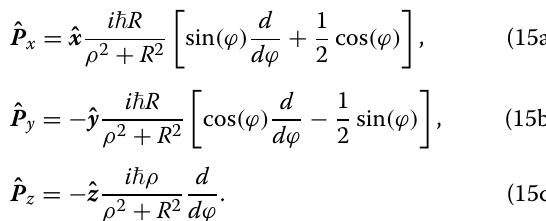
cally. To understand this behaviour, we must consider the special case of q = 0. As we traverse this resonance, the energy of the Bloch function with q = 0 constructed from the first excited state of the deeper well in the DQW unit cell ( p -like) passes below the Bloch function constructed from the ground state in the shallower well ( s -like).